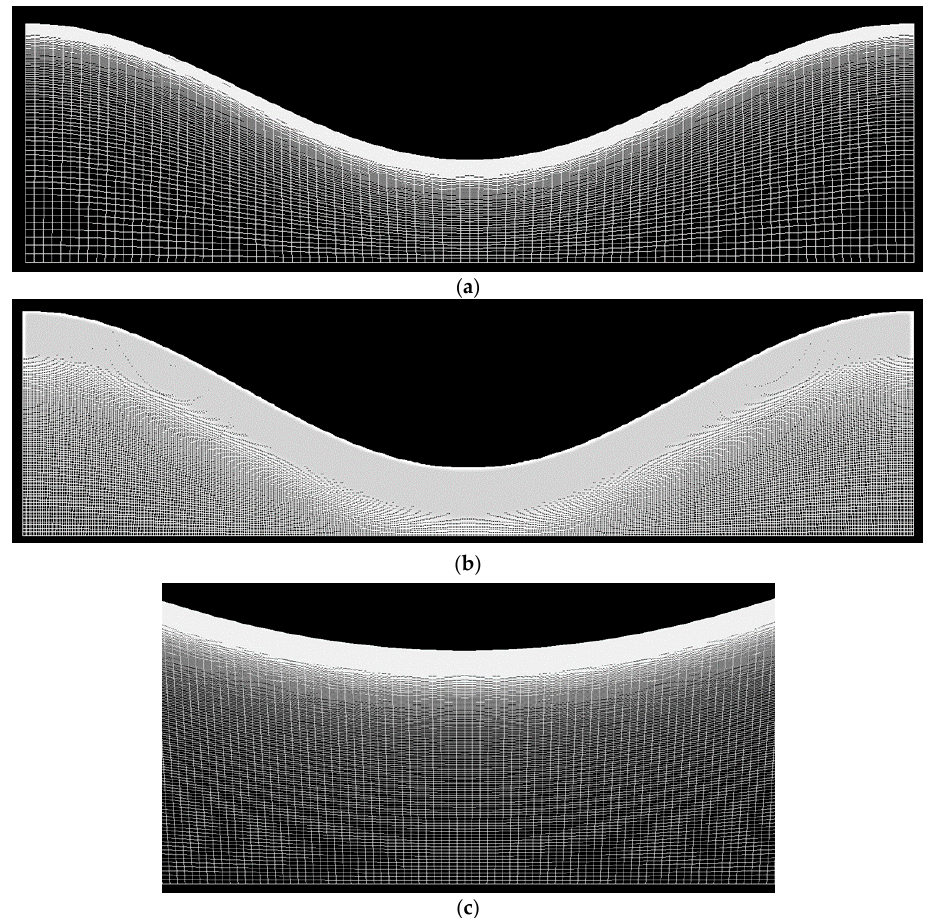
Figure 2. Typical grid used for the Computational Fluid Dynamics (CFD) computations of ( a ) laminar and ( b ) turbulent flow, and ( c ) magnified view.